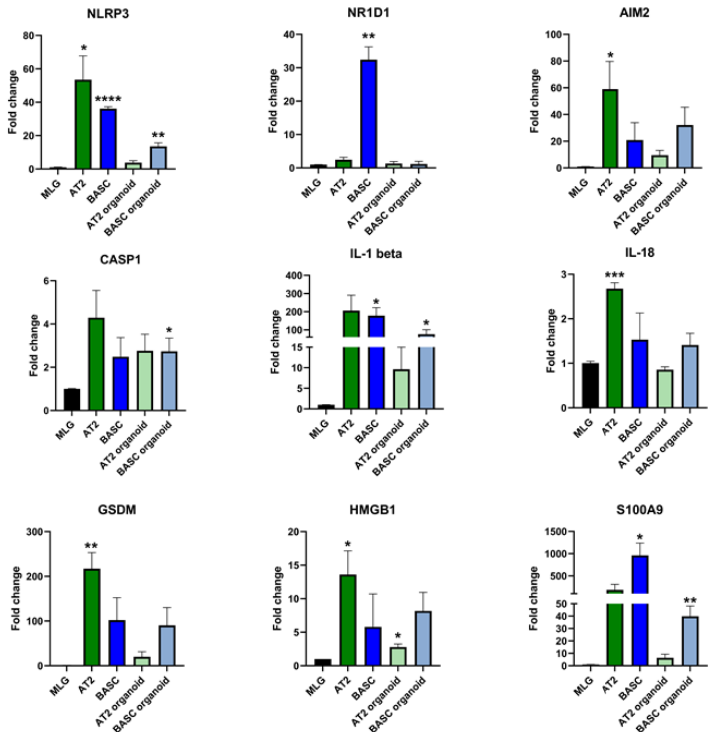
Figure 3. Relative mRNA expression of the genes involved in NLRP3 inflammasome . Lung fibro- blast cell line (MLG) was used as reference point for all examined genes expression. In order